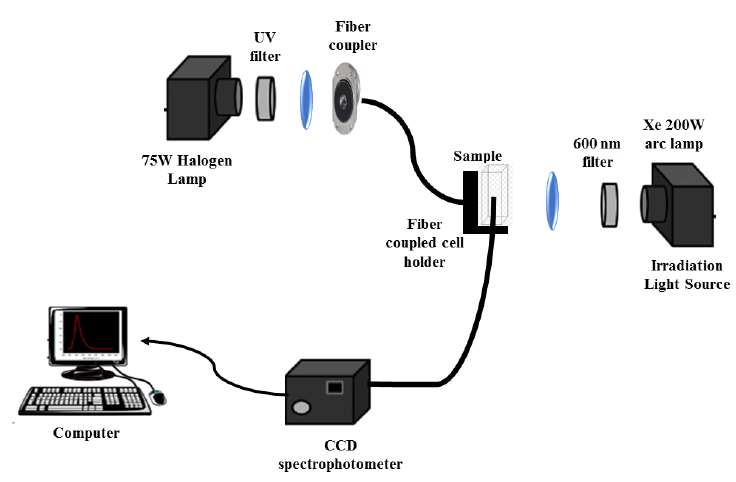
Figure 1. Experimental set-up for measurements of the photothermal effect.